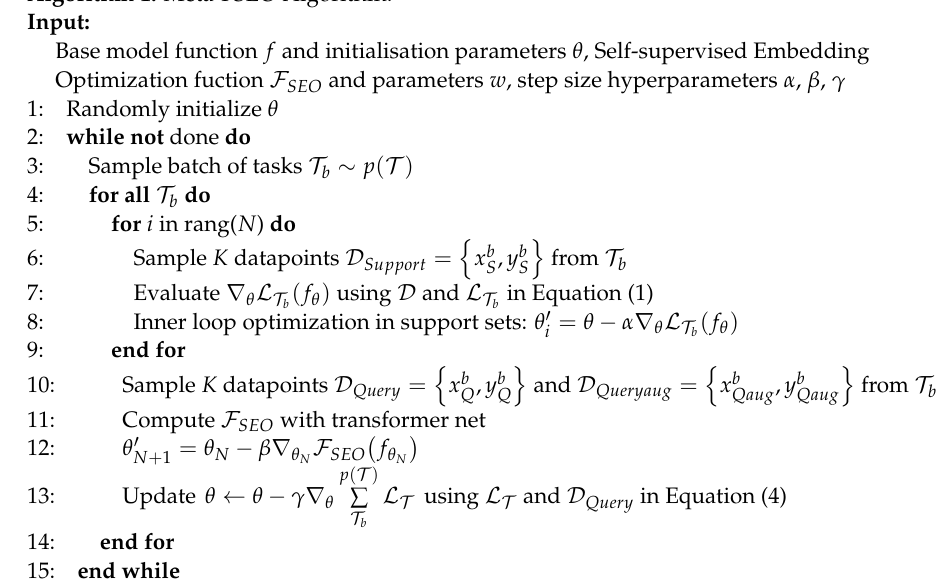
Algorithm 1: Meta-FSEO